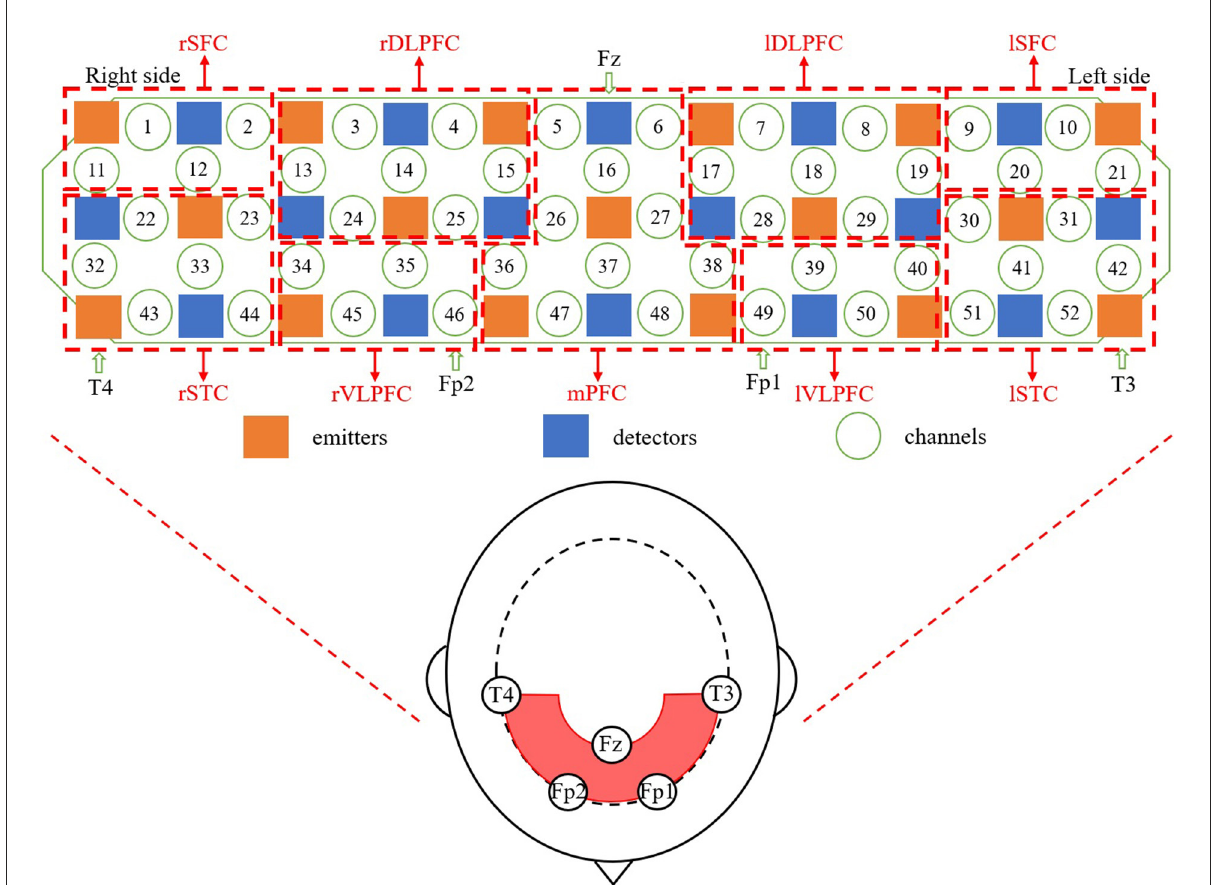
FIGURE2 The positions of fNIRS probes and channels according to the international 10–20 system. rSFC, right superior frontal cortex; rDLPFC, right dorsolateral prefrontal cortex; lDLPFC, left dorsolateral prefrontal cortex; lSFC, left superior frontal cortex; rSTC, right superior temporal cortex; rVLPFC, right ventrolateral prefrontal cortex; mPFC, medial prefrontal cortex; lVLPFC, left ventrolateral prefrontal cortex; lSTC, left superior temporal